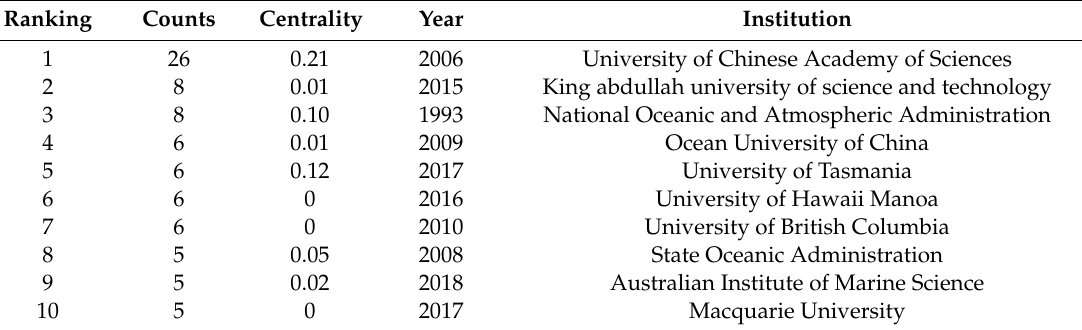
Table 2. Top 10 most productive institutions regarding big ocean data documents.